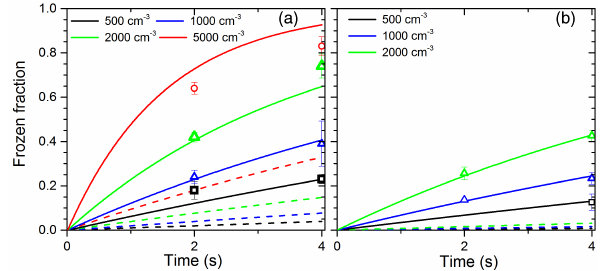
Figure 4. Evolution of the frozen fraction as a function of the res- idence time in the chamber calculated for different particle con- centrations from 500 to 5000cm − 3 . Solid lines are calculated with Eq. (19) assuming a collision efficiency E exp = 0 . 13 and dashed lines for E = 0 . 02 for 200nm particle in (a) , while in (b) E exp = 0 . 07 and E = 0 . 004 for 400nm particles. Symbols and uncertainty bars give the average and standard deviation of the frozen fraction plateau values indicated by open symbols in Fig. 3.